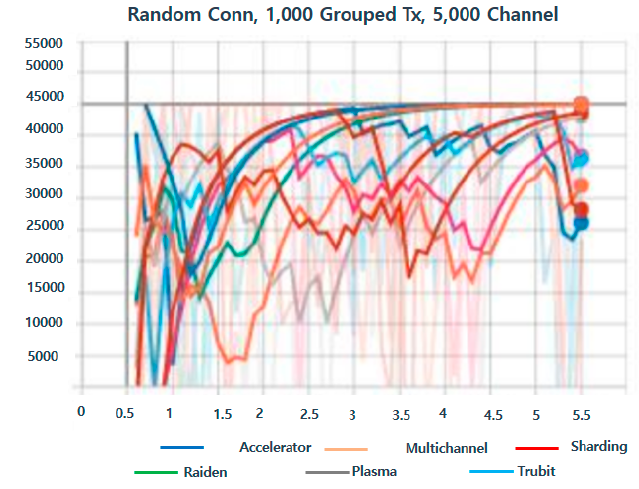
Figure 11. 1000 Grouped Tx, 5000 Channel.